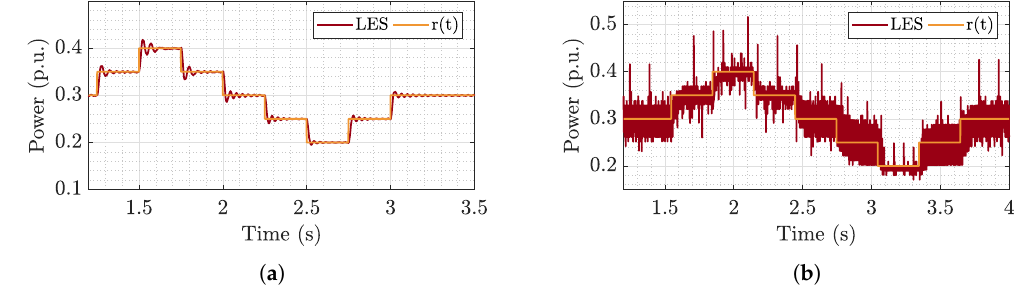
Figure 11. Output power for CPL boost during the ( a ) simulation and ( b ) test.